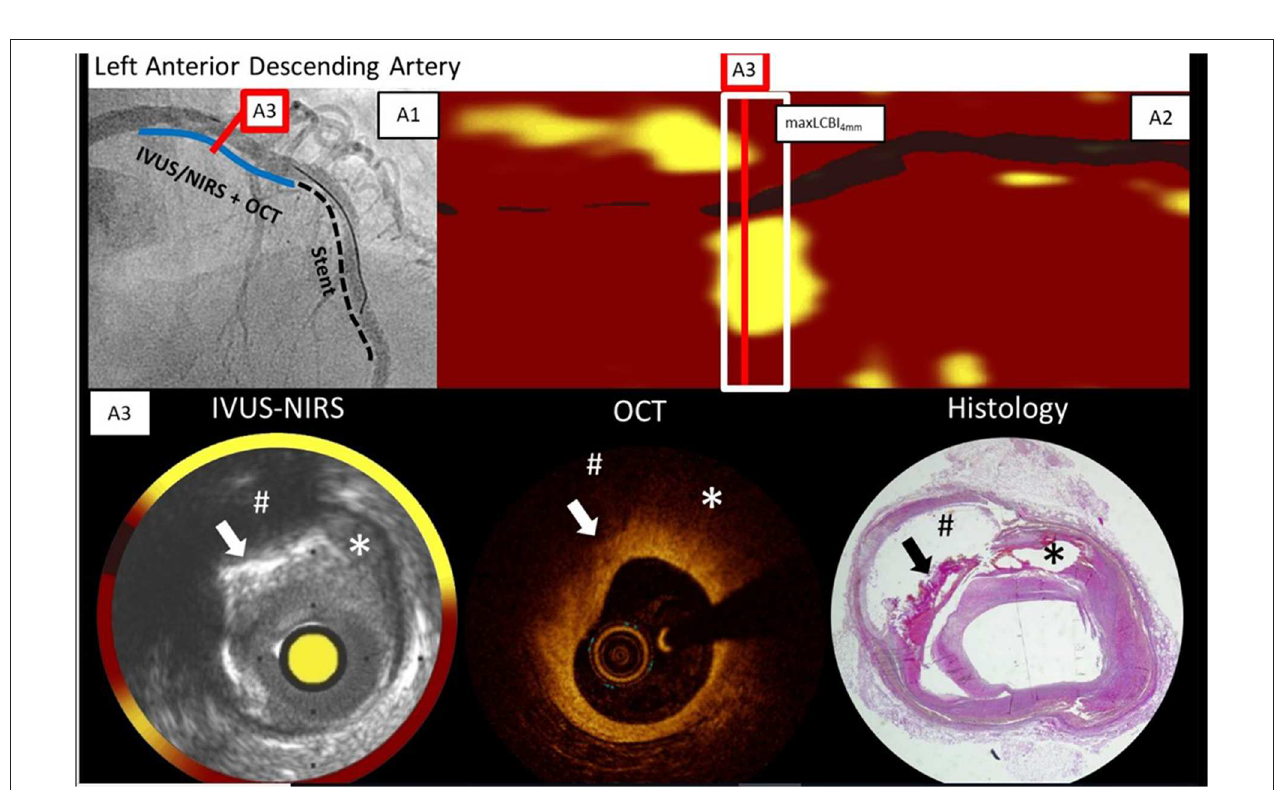
FIGURE 5 | Angiogram, NIRS, OCT, and histology findings in a patient who died of ventricular rupture 5 days after imaging. The blue line on the angiogram (A1) shows the IVUS-NIRS and OCT pullback location in LAD during stenting at a more distal location. The chemogram (A2) and cross-section IVUS-NIRS (A3) shows lipid from 10 p.m. to 3 p.m. OCT from the same cross-section shows a thick cap of 300 microns, and signs of calcification which complicate the detection of lipid by OCT. In each image, the arrow marks the location of superficial calcium, the hash-tag marks the location of a lipid core underlying the calcification, and the the asterisk marks the location of a lipid pool. Adapted from Zanchin et al. (49). The findings show the complementarity of NIRS and OCT data—NIRS identifies lipid without interference by calcium and OCT shows the thickness of the cap over the lipid. In this case in which the plaque was not causing obstruction, the lipid core would not be expected to be dangerous since a thick cap is